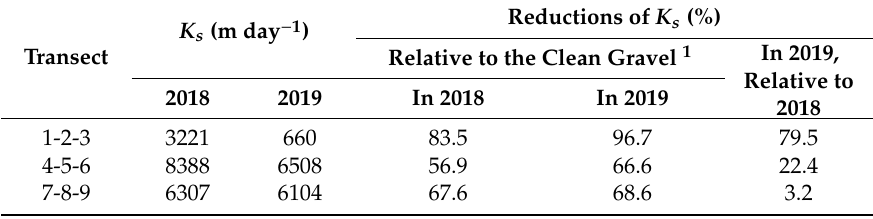
Figure 3. Mean of K s (m day − 1 ) values (N = 4) for the nine piezometers inside the HSTW bed ( a ) in 2018 [18] and 2019 ( b ). K s hydraulic conductivity at saturation. Table 3. Spatial and temporal variation of the K s (m day − 1 ) values along the main transects in 2018 [18] and 2019.